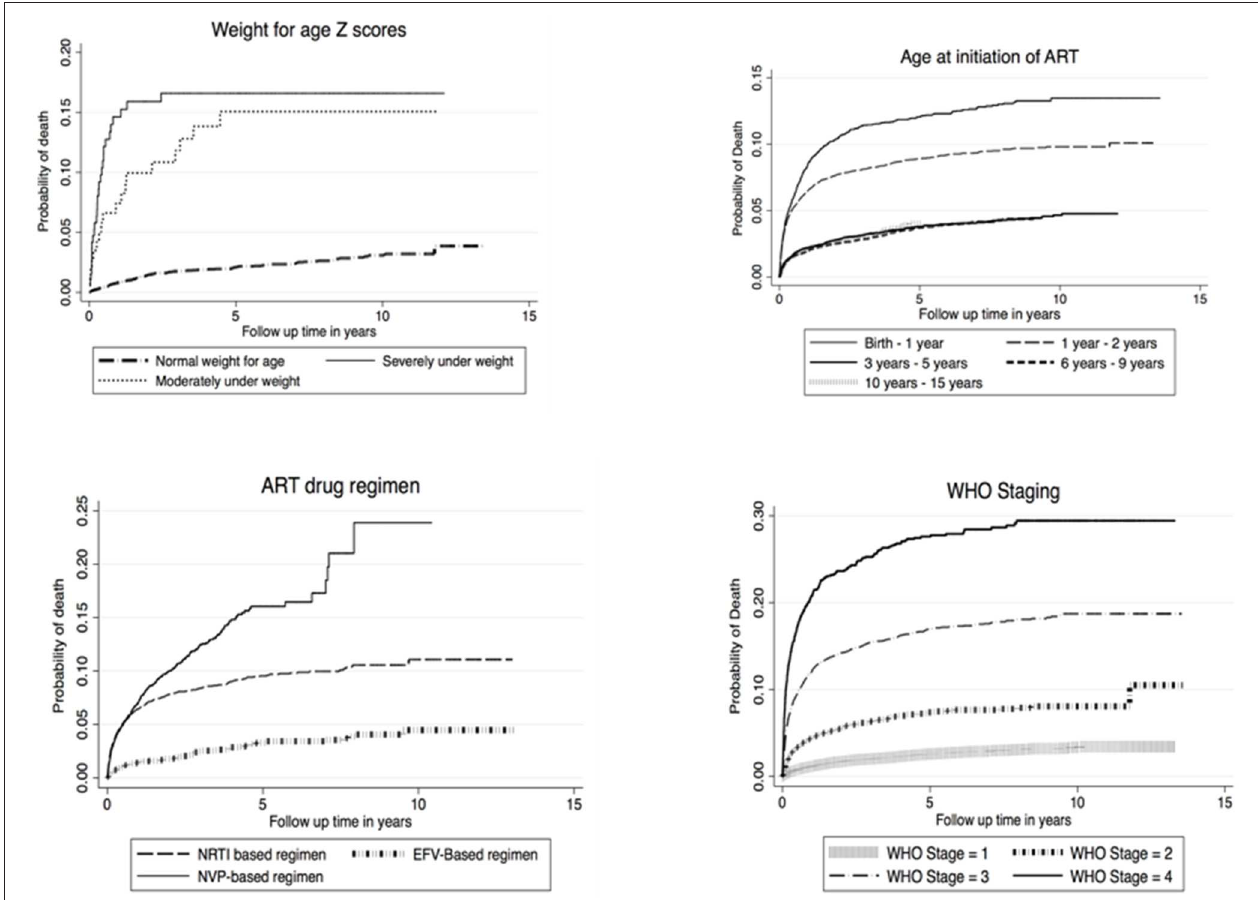
FIGURE 1 | Nelson Aalen cumulative Hazard